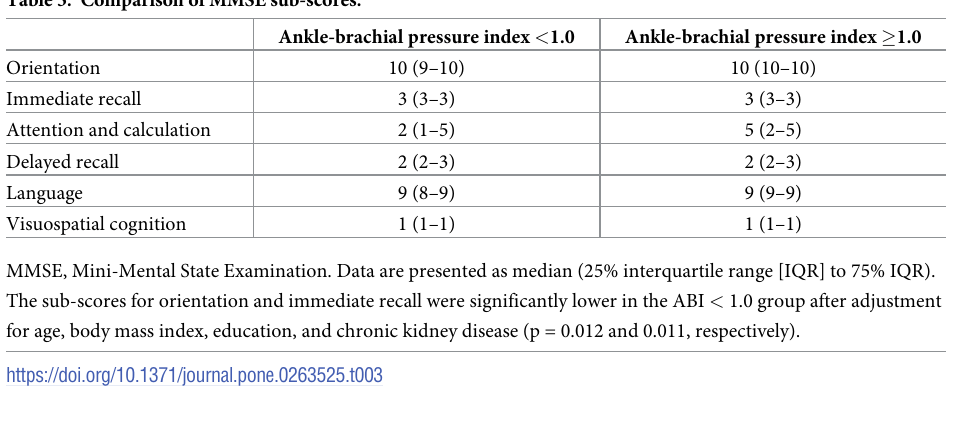
Table 3. Comparison of MMSE sub-scores.